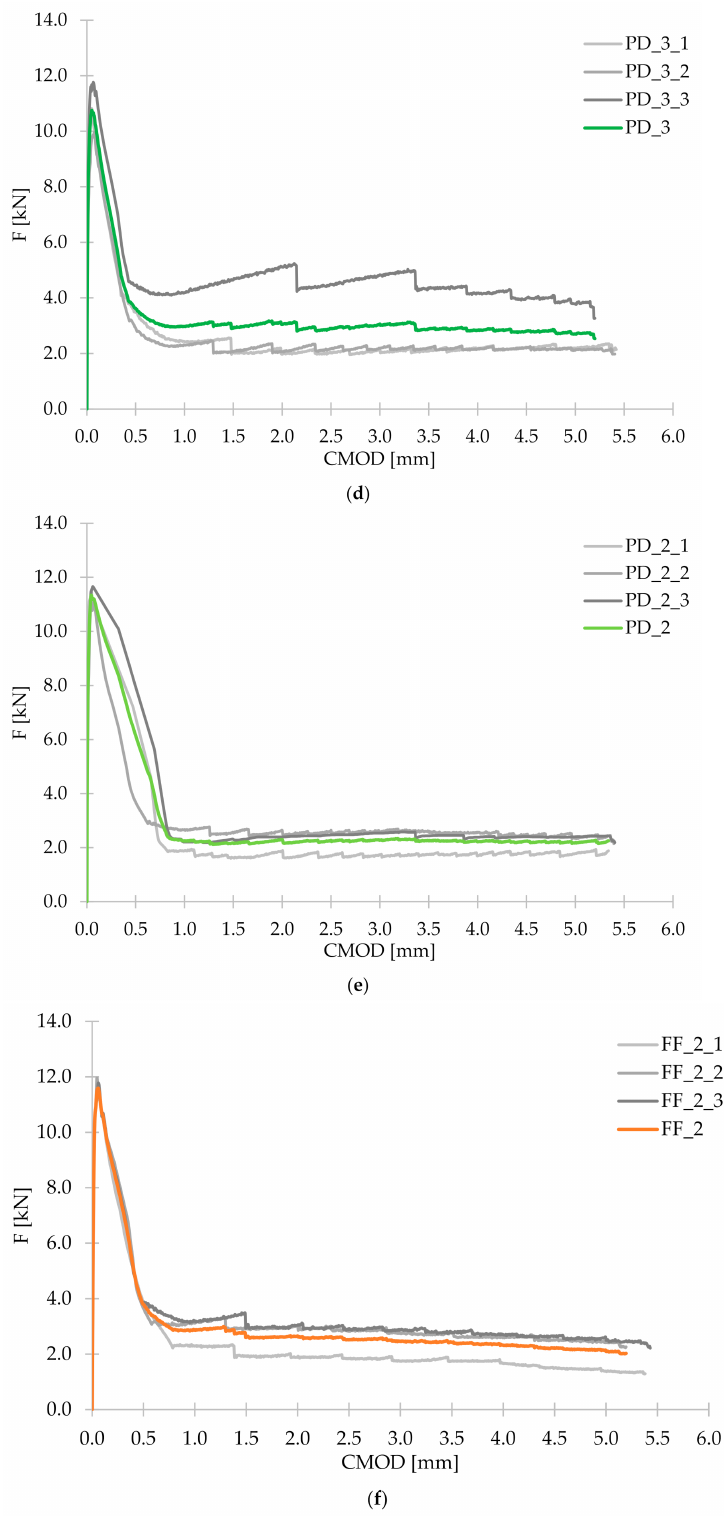
Figure 10. Graphs of mean F-CMOD curves for ( a ) PC; ( b ) PM_3; ( c ) PM_2; ( d ) PD_3; ( e ) PD_2; ( f ) FF_2 with graphs of the individual samples within the